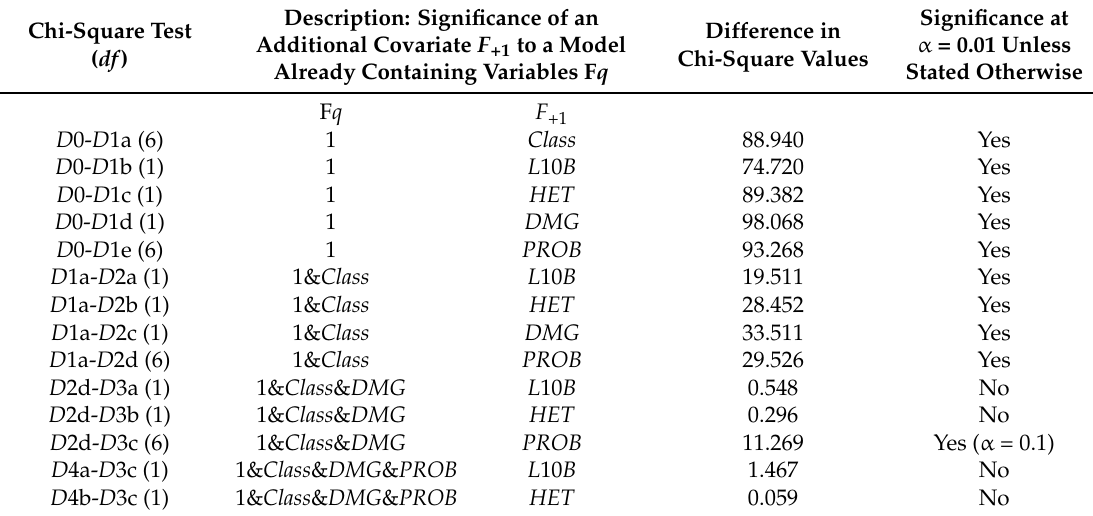
Table 4. Chi-square tests for selected